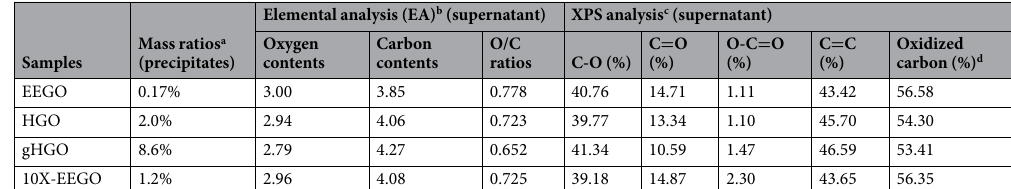
Table 1. The EA and XPS data of the GO samples. a The ratios of un-exfoliated precipitate to the initial mass of graphite powders in the corresponding synthesis. b The ratios of oxygen contents divided by carbon contents from EA. c The percentages of each species are calculated based on the peak areas after deconvolution relative to that of the whole carbon signals. d The ratios of the sum of all the oxidized carbon species versus the unoxidized carbon species (C =